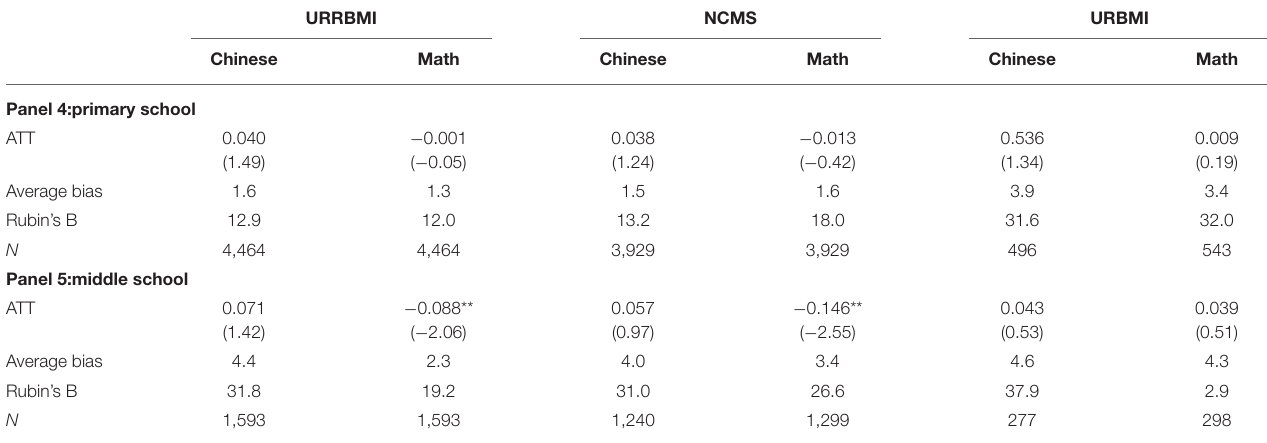
TABLE 7 | PSM estimates for different subgroups.